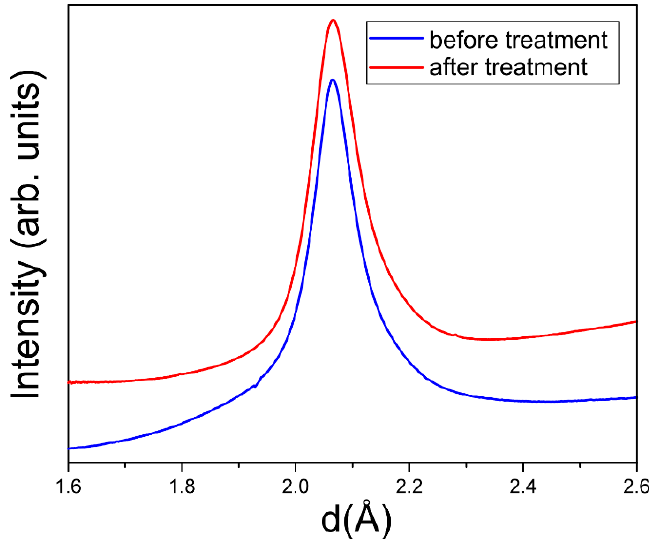
Figure 5. Profile of 111 diamond diffraction peak before and after the deagglomeration treatment. Graphs are shifted along the vertical axis for the visibility.